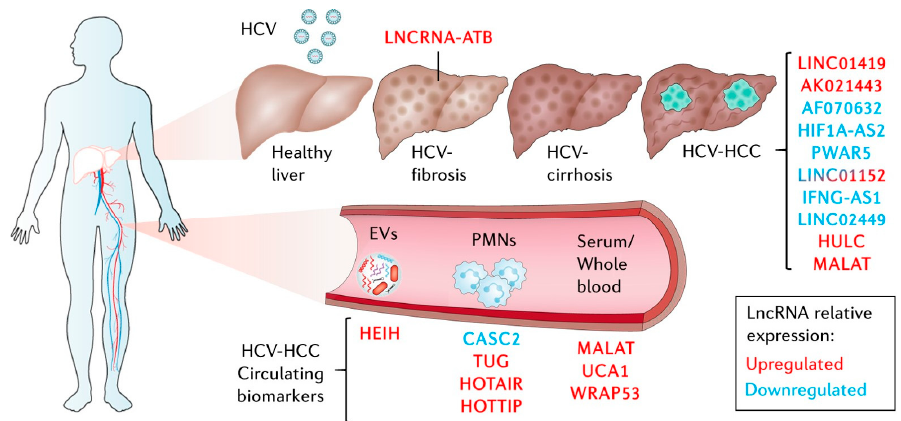
Figure 3. LncRNAs deregulated in HCV-hepatocellular carcinoma (HCC) in tumor samples and cell studies or as circulating biomarkers in liquid biopsies. EVs: extracellular vesicles, PMNs: polymorphonuclear leukocytes. See text for details.